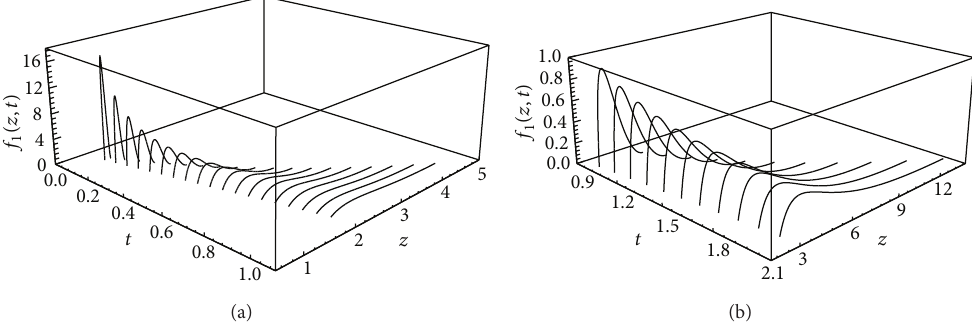
Figure 10: Plot of 𝑓 1 (𝑧,𝑡) given by (96) in Example 20 at different values of 𝑡 = {0,0.1, 0.2, .. ., 1} (a) and 𝑡 = {0.9, 1,1.1, . .. ,2} (b) in the case that 𝐴 ∼ Be (2;3) , 𝑡 0 = 0 , 𝑧 0 = 1 , and 𝑏 = 1 . In order to highlight better the shape of 𝑓 1 (𝑧, 𝑡) , we have split its representation into two plots. Notice the different scales in the vertical axes for each plot.